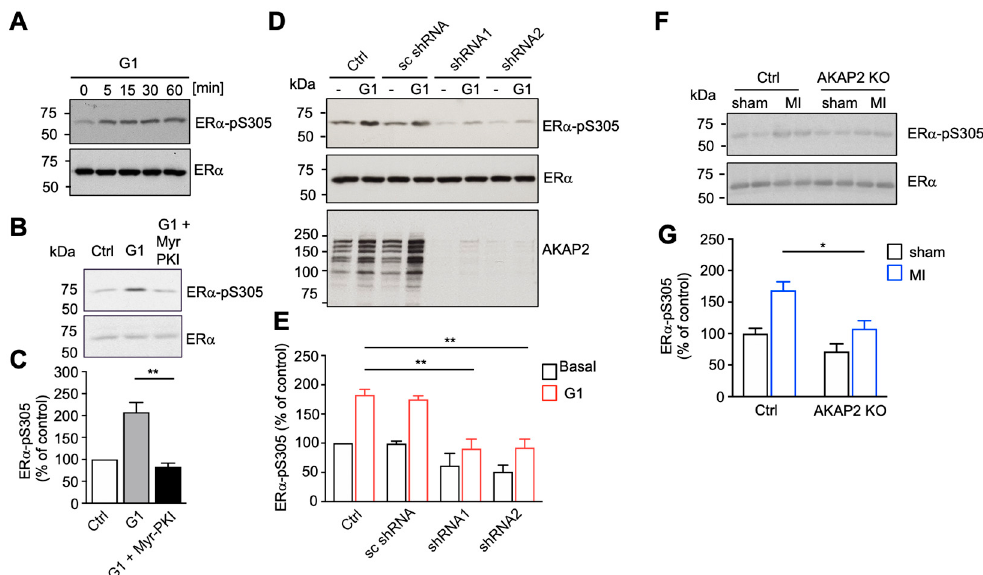
Figure 5. AKAP2 favors PKA-mediated phosphorylation of ERa. ( A ) Rat NVMs were serum starved for 24 h and subsequently treated with 10 − 7 M G1 for the indicated periods of time. Phosphorylation of S305 on ER α was revealed by Western blot, using phospho-specific antibodies. ( B , C ) Rat NVMs were serum starved for 24 h and subsequently treated with or without 10 − 7 M G1 for 15min in the presence or absence of 10 − 6 M Myr-PKI. Phosphorylation of S305 on ER α was revealed by using phospho-specific antibodies. The amount of phospho-ER α was normalized to the total amount of ER α . Results are expressed as mean ± SE of 3 experiments; ** p < 0.01. ( D , E ) Rat NVMs were infected by using control lentiviruses or lentiviruses encoding wild type (AKAP2 shRNA 1 and 2) or scrambled (sc shRNA) AKAP2 shRNAs. Cells were serum starved for 24 h and subsequently treated with or without 10 − 7 M G1 for 15min. Phosphorylation of S305 on ER α was revealed and quantified as indicated in ( B , C ). Expression of AKAP2 in the lysates was assessed by immunoblot, using specific antibodies. Results are expressed as mean ± SE of 3 experiments; ** p < 0.01. ( F , G ) Cardiac lysates were prepared from control (Ctrl) or cardiomyocyte-specific AKAP2 KO mice 24 h after sham operation or LAD ligation (MI). Phosphorylation of ER α S305 was assessed by Western blot and quantified as indicated in ( B , C ). Ctrl-sham n = 4, Ctrl-MI n = 4, AKAP2 KO-sham n = 4, AKAP2 KO-MI n = 4; * p <